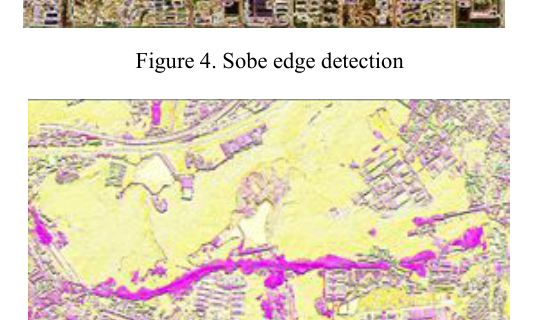
Figure 9. MRF segmentation